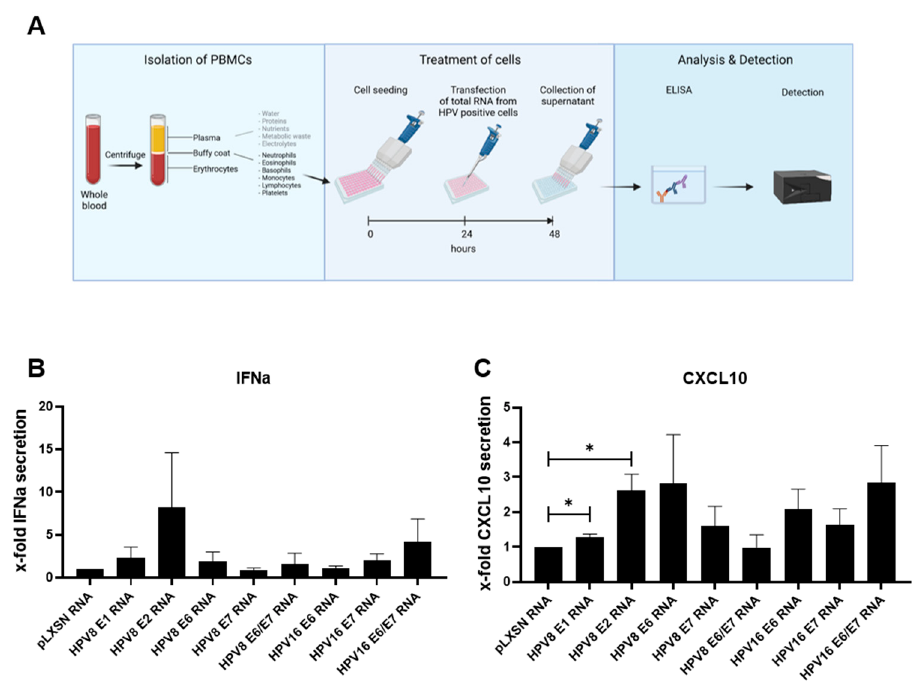
Figure 5. PBMCs secrete elevated cytokine levels upon stimulation with total RNA isolated from HPV8 ‐ E2 ‐ expressing keratinocytes. Total RNA from primary keratinocytes expressing distinct HPV8 or HPV16 genes was collected and transfected into PBMCs from six individual donors. Supernatants were harvested 24 h post ‐ transfection, and IFN ‐ a ( B ) and CXCL10 ( C ) were analyzed by ELISA, as shown in the schematic assay workflow (created with BioRender.com (accessed on 3 May 2022, ( A )). Presented is the x ‐ fold IFN ‐ a or CXCL10 secretion ± SEM normalized to the values obtained with RNA isolated from pLXSN ‐ expressing cells. * p < 0.05.